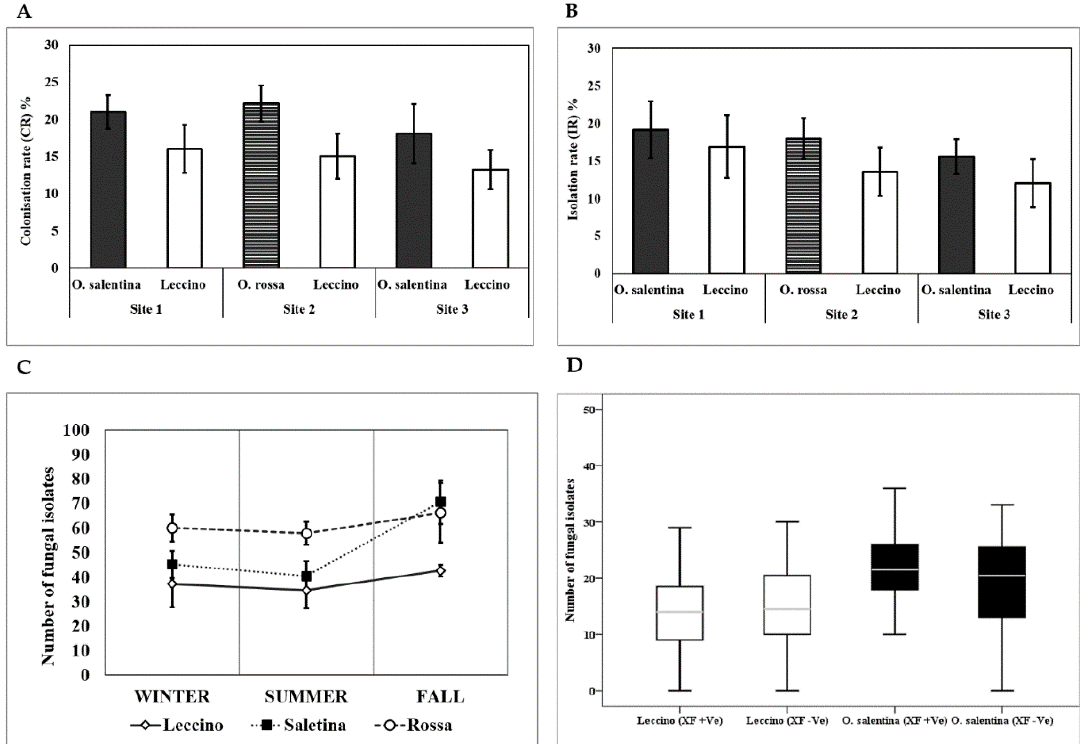
Figure 6. Illustrations of fungal endophytes occurrence and variations. ( A ) The histogram illustrates the variation of fungal colonization rates between different olive varieties belonging to different sampling sites. Bars represent SEM. ( B ) The histogram shows the variation of fungal isolation rates between different olive varieties belonging to different sampling sites. Bars represent Std. ( C ) The curves illustrate the representative mean number of fungal isolates ± Std, which represents the seasonal dynamic of fungal endophytes occurrence within different olive varieties. ( D ) Boxplot depicts the interactive effect of ‘Leccino’ and ‘O. salentina’ health status varieties on the mean number of isolates.